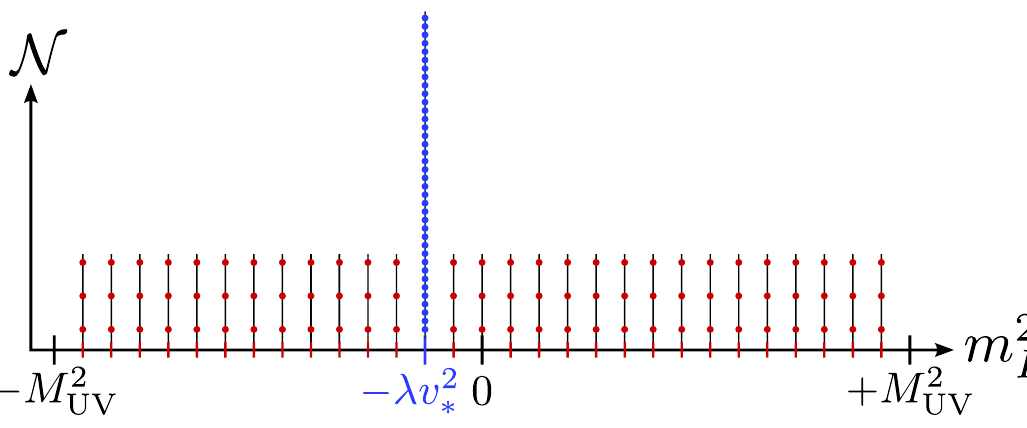
Figure 1 . Schematic representation of the number the cosmological constant down to a small value as a function of the Higgs